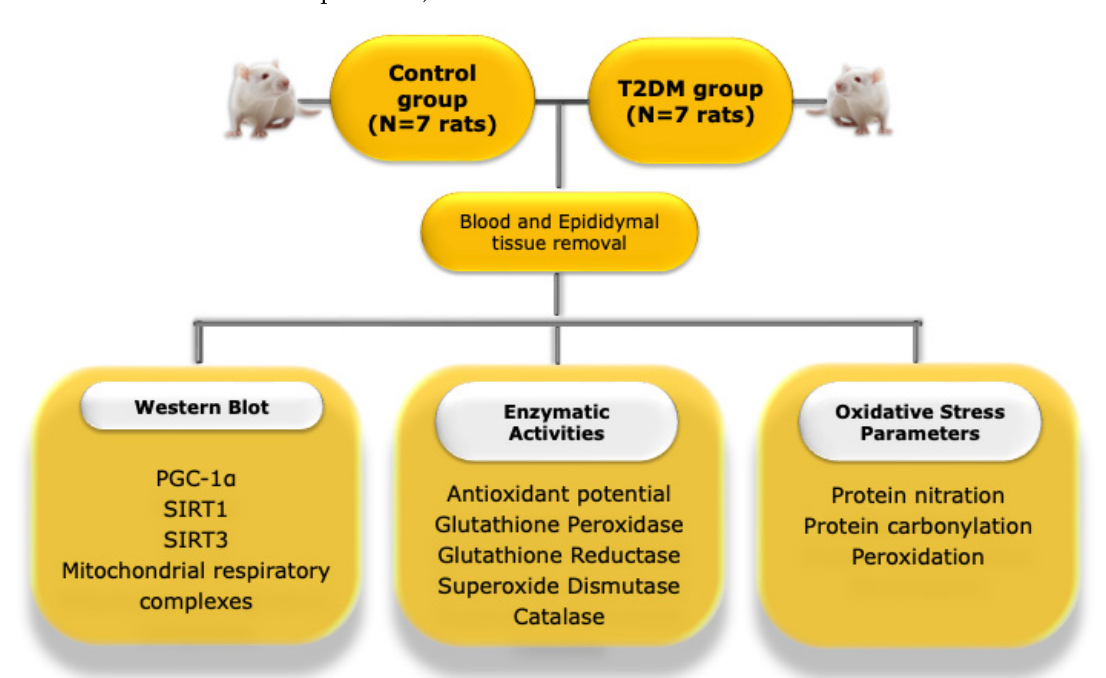
Figure 6. Illustrative representation of the experimental layout of the study. PGC-1 α —peroxisome proliferator-activated receptor coactivator 1 α ; T2DM—type 2 diabetes mellitus; SIRT1—Sirtuin 1, SIRT3—Sirtuin 3.